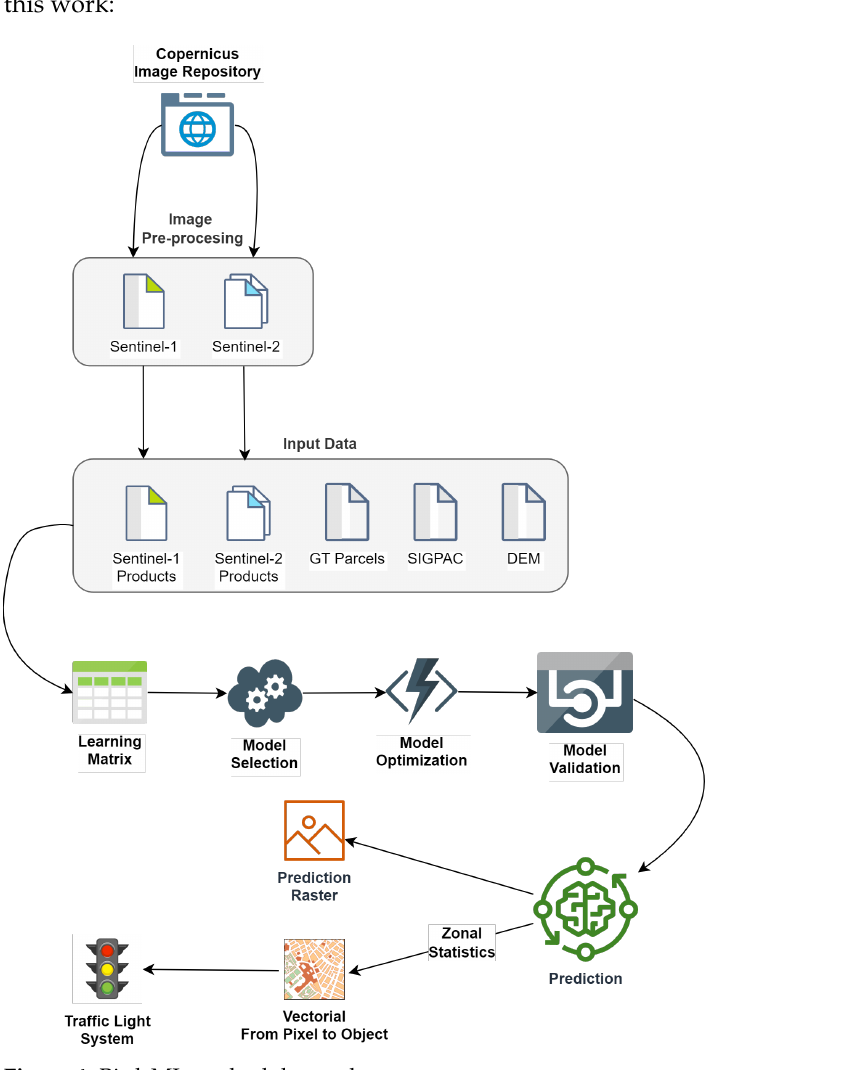
Figure 4. BirdsML methodology